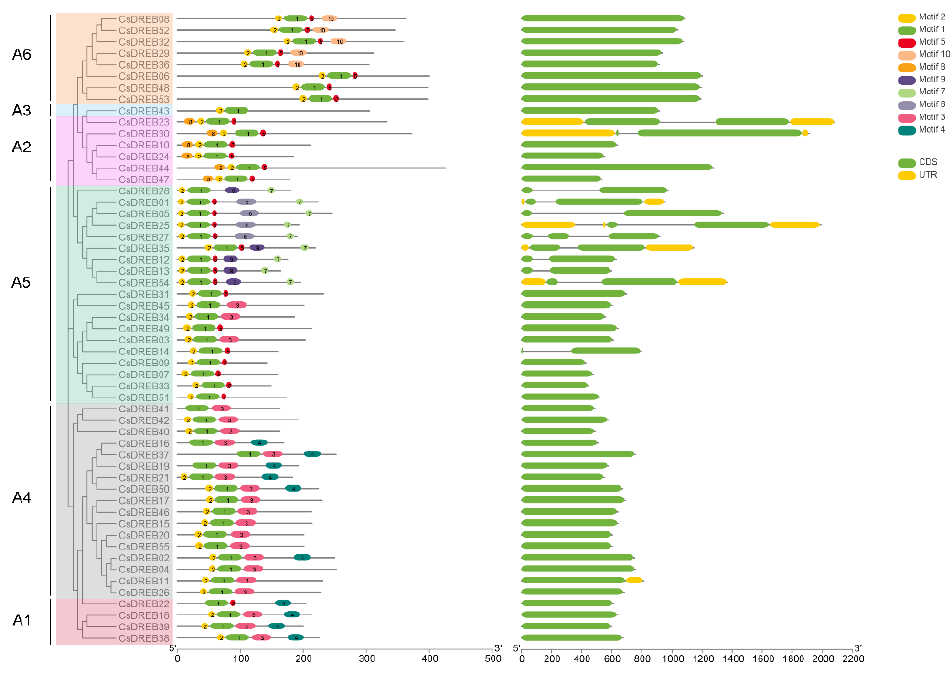
Figure 3. Analysis of phylogenetic relationships, gene structures, and motifs in cucumber: Left panel—the phylogenetic tree was constructed from the sequences of CsDREB proteins. The different groups are shown in different colors. Middle panel—different colored boxes represent the motifs of CsDREB; The details of each motif are shown in Table S4. Right panel—gene structure of CsDREB TFs; 5′- and 3′-regions, exons, and introns are indicated by green boxes, yellow boxes, and grey lines, respectively. The gray numbered line at the bottom represents gene length.